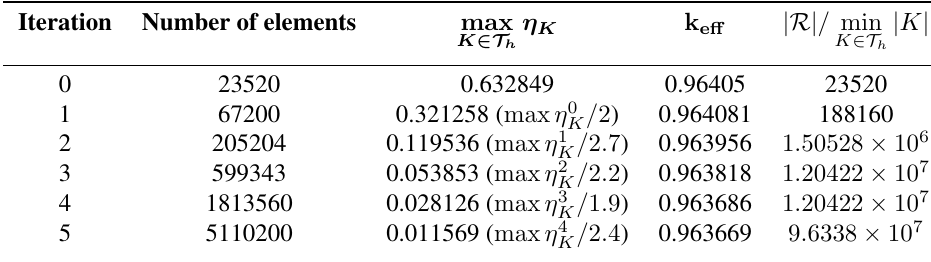
Table 1: Data of adaptive mesh refinement by using direction marker method